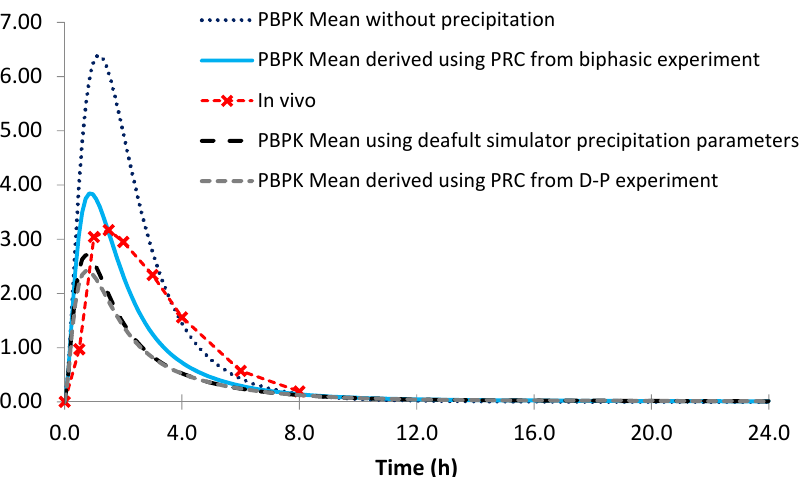
Figure 11. Simulated plasma profile vs. in vivo plasma profile (dashed line with crosses) of ketoconazole after a single oral dose of ketoconazole 200 mg, based on the design of the clinical study by Daneshmend et al. [23]. The in vivo plasma profile is represented by the red dashed line with crosses. The simulated plasma profile derived from the biphasic dissolution data, the D-P data, the PBPK default simulator parameters and the profile without precipitation are represented by the solid blue line, the dashed grey line, the dashed black line and dotted dark blue line, respectively.